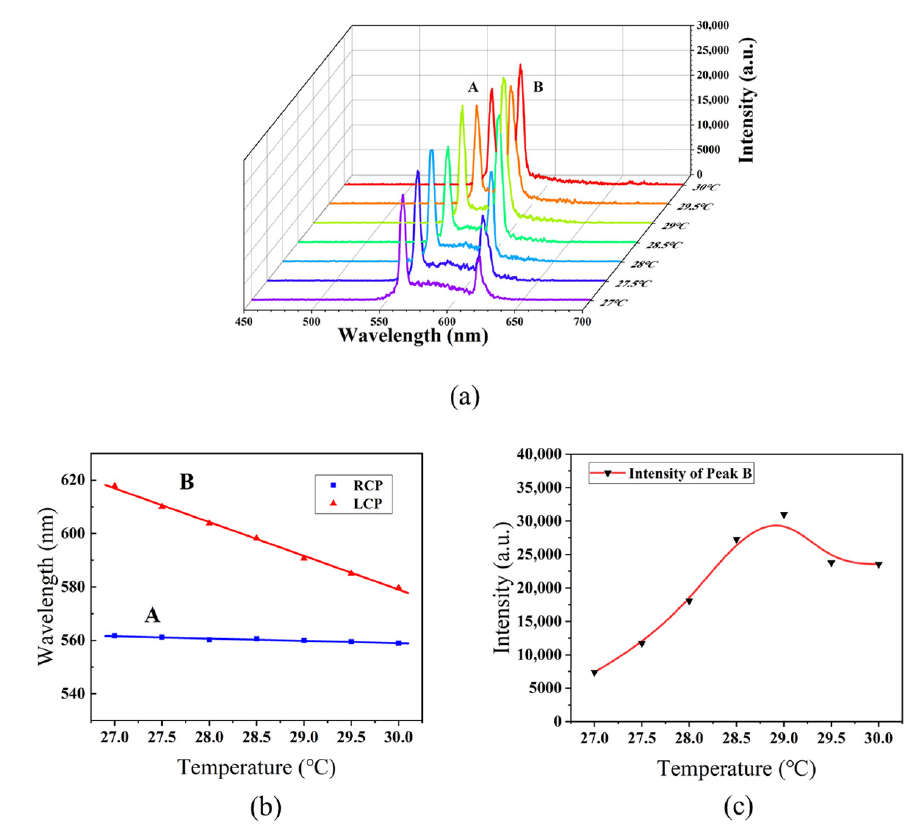
Figure 8. ( a ) Dual-wavelength laser emission spectra at different temperatures; ( b ) lasing wavelengths with orthogonal circular polarizations as a function of temperature; ( c ) lasing intensity of Peak B as a function of temperature.